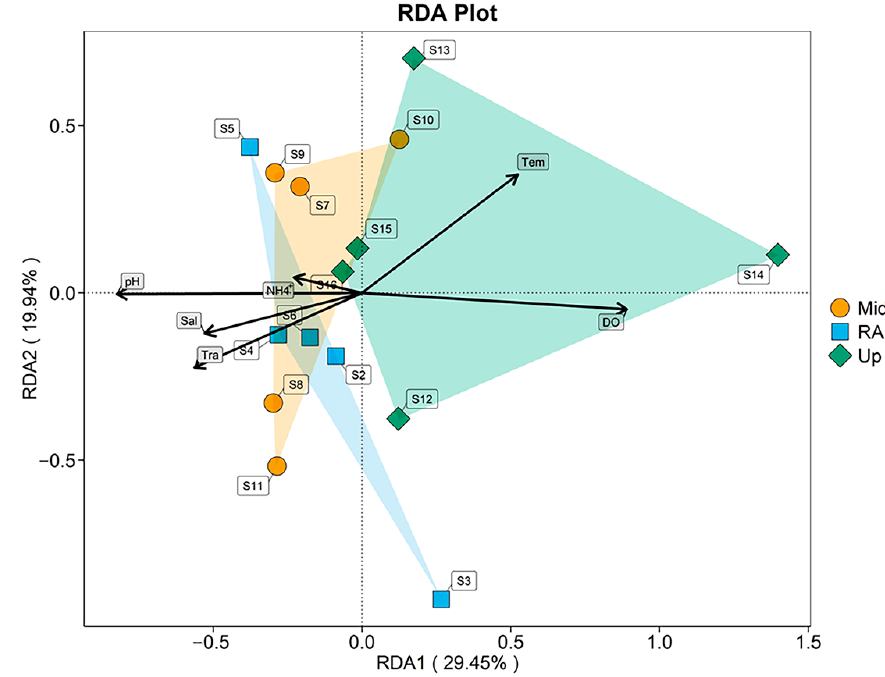
Figure 4. RDA analysis of fish OTU sequence reads. Different segment sample points are